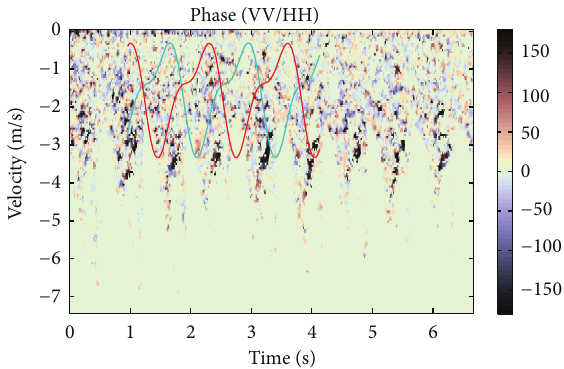
Figure 5: Repeated polarimetric measurement of a human walking away from the radar at Ka band. The black double-bounce areas correspond to the elbow motion, while the white and grey single- bounce area is the rest of the body. The simulated motions of the knee are superimposed on the image, showing a rough correspon- dence to areas of high